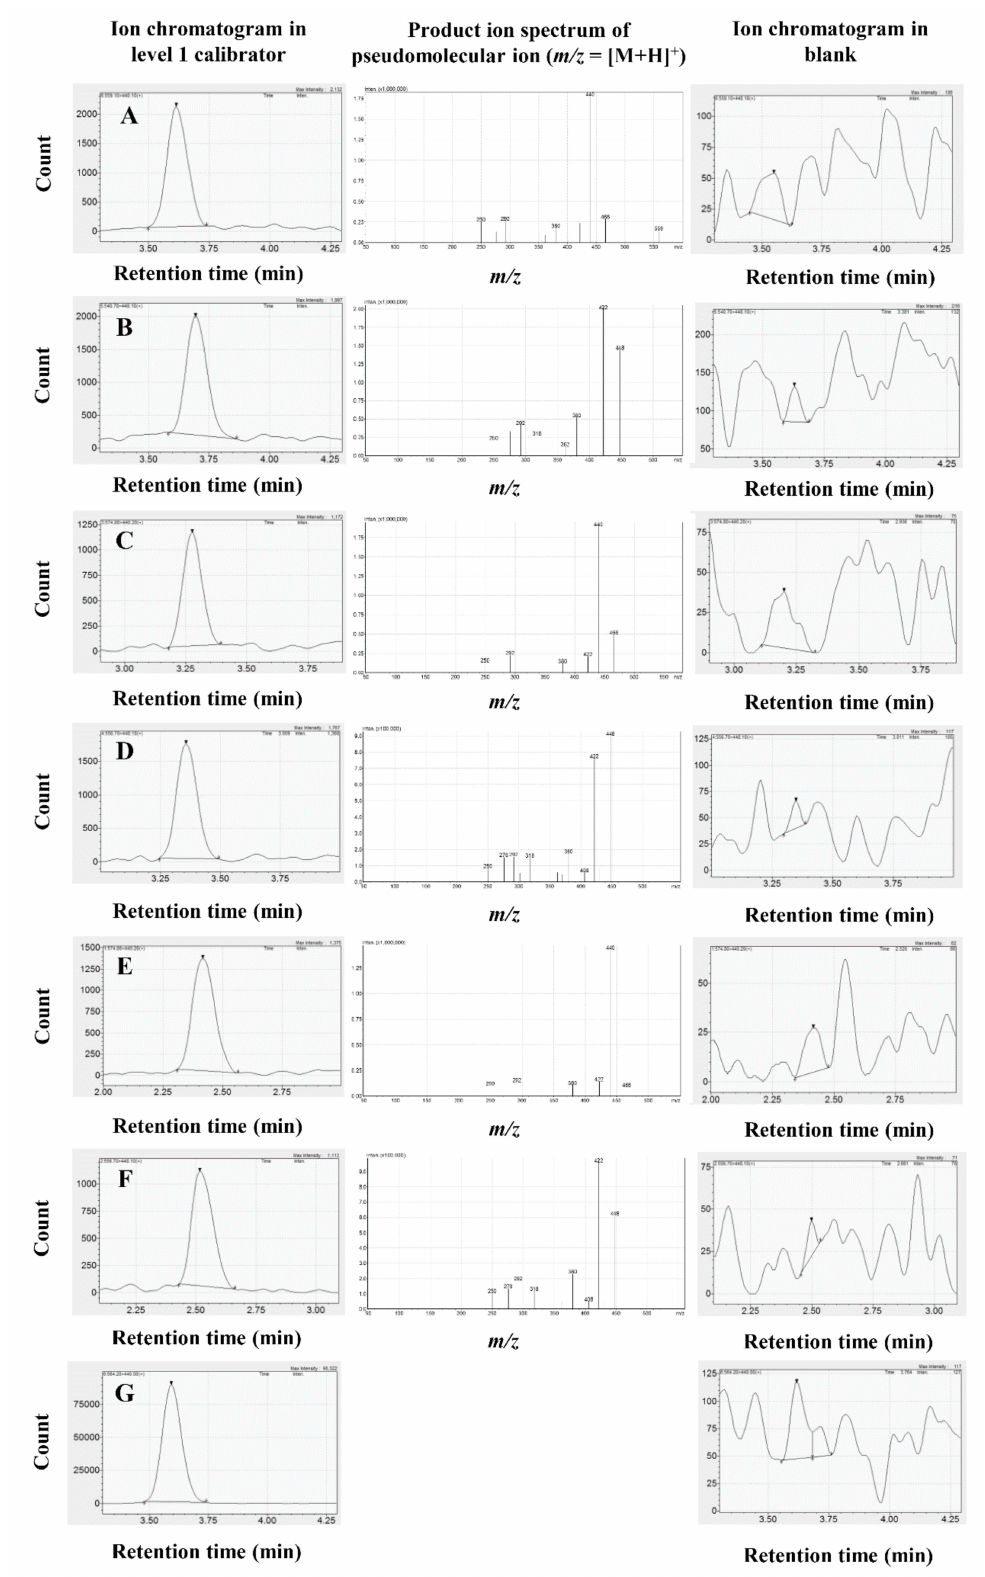
Figure 2. Representative ion chromatograms and product ion mass spectra of the analytes. The product ion mass spec- tra were recorded between m/z = 50 and m/z = [M + H] + , and the collision energy was − 25 V. ( A ) Atorvastatin (1.79 nmol/L), ( B ) Atorvastatin lactone (1.85 nmol/L), ( C ) 2-hydroxyatorvastatin (1.87 nmol/L), ( D ) 2-hydroxyatorvastatin lactone (1.80 nmol/L), ( E ) 4-hydroxyatorvastatin (1.74 nmol/L), ( F ) 4-hydroxyatorvastatin lactone (1.80 nmol/L), ( G